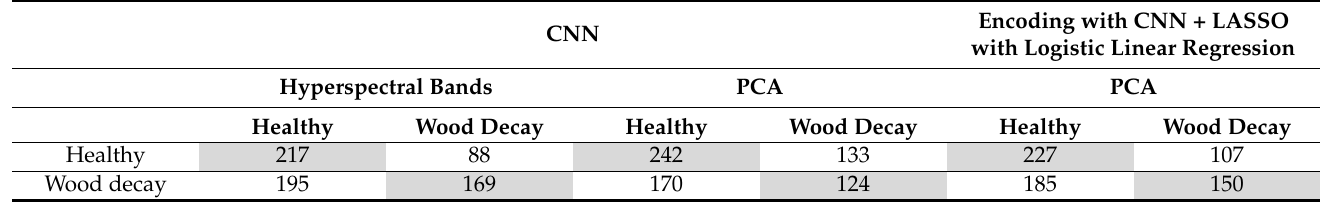
Table 8. Confusion matrices of the models with unaggregated pixels for Dataset II. The cells with gray background are the main diagonal of the confusion